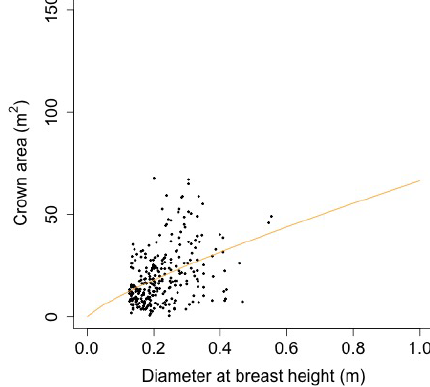
Figure D11. Crown area model fit to FIA Forest Health Monitoring data for Robinia .